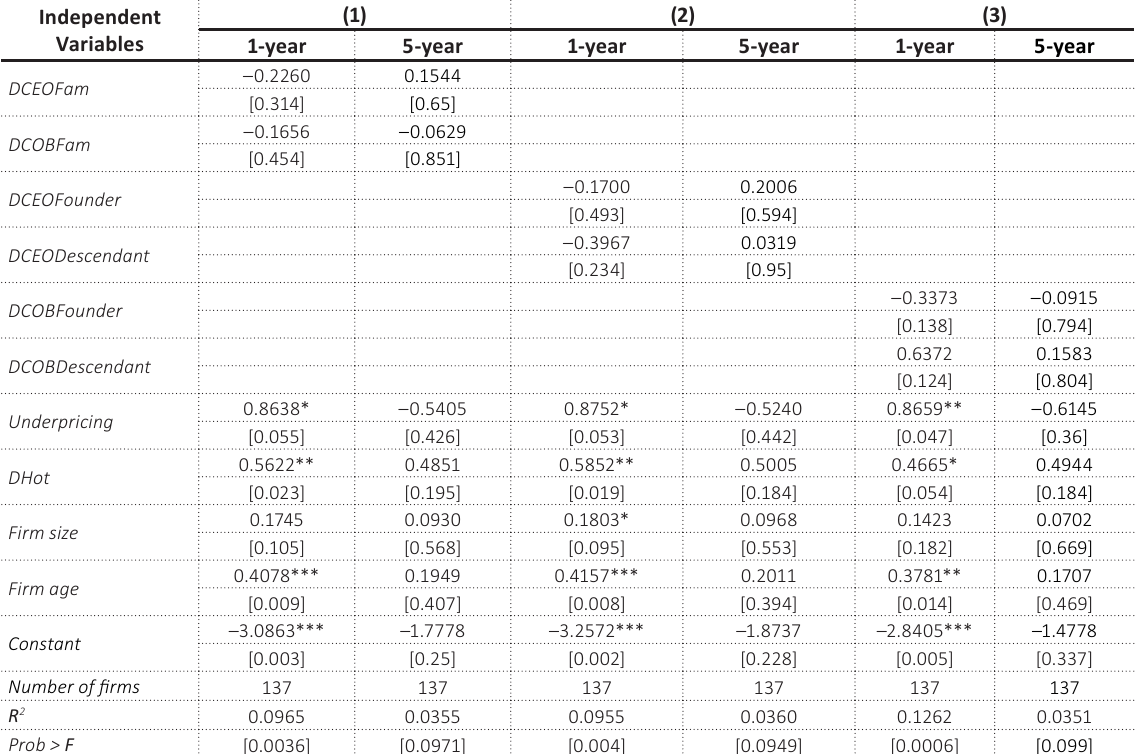
Table 7. Effect of family involvement on IPO long-run